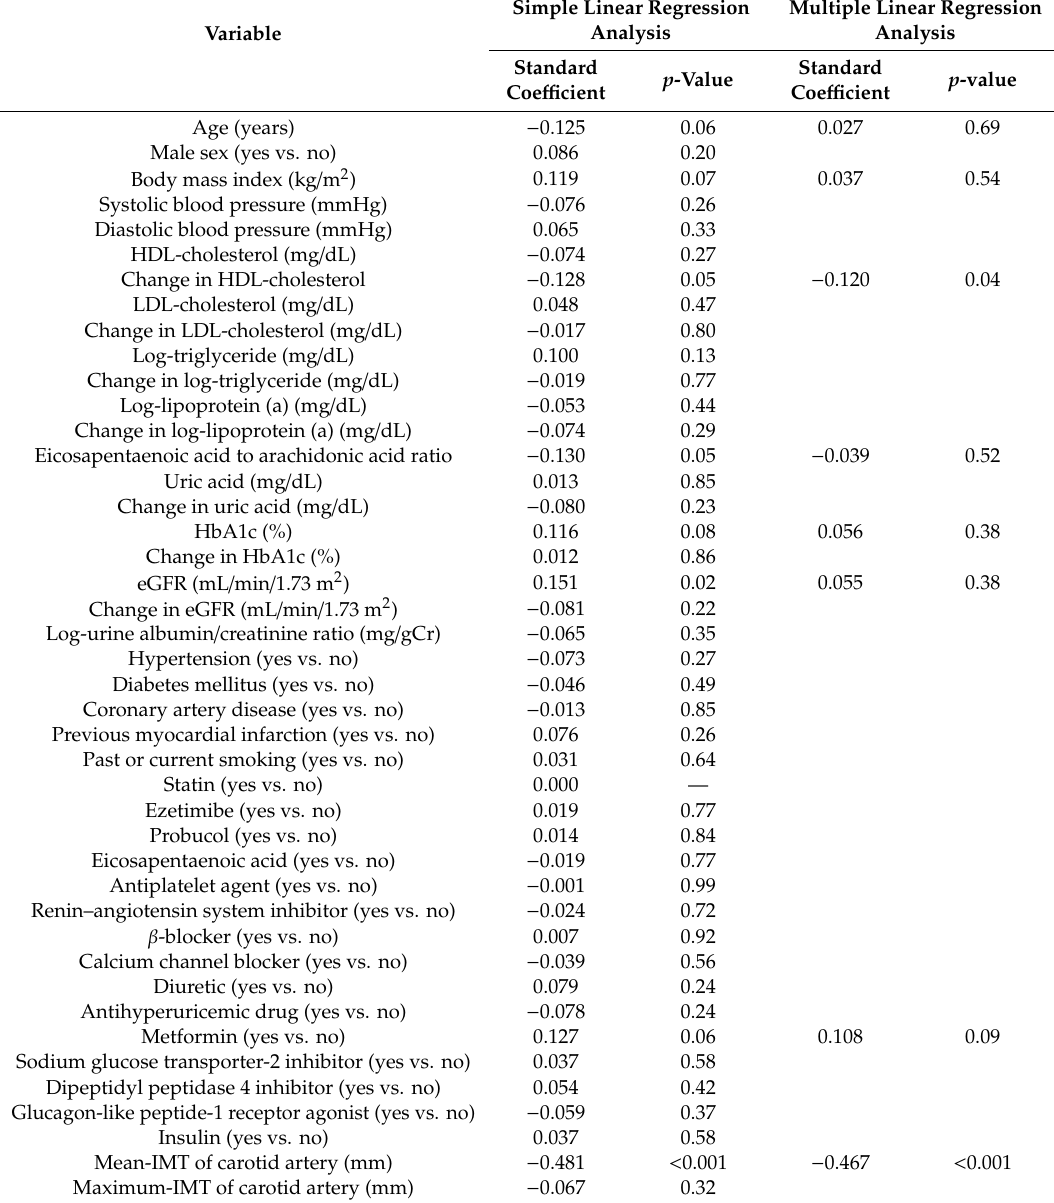
Table 3. Simple and multiple linear regression analyses of variables potentially associated with the change in carotid mean IMT during the administration of evolocumab. Simple Linear Regression Multiple Linear Regression Analysis Variable